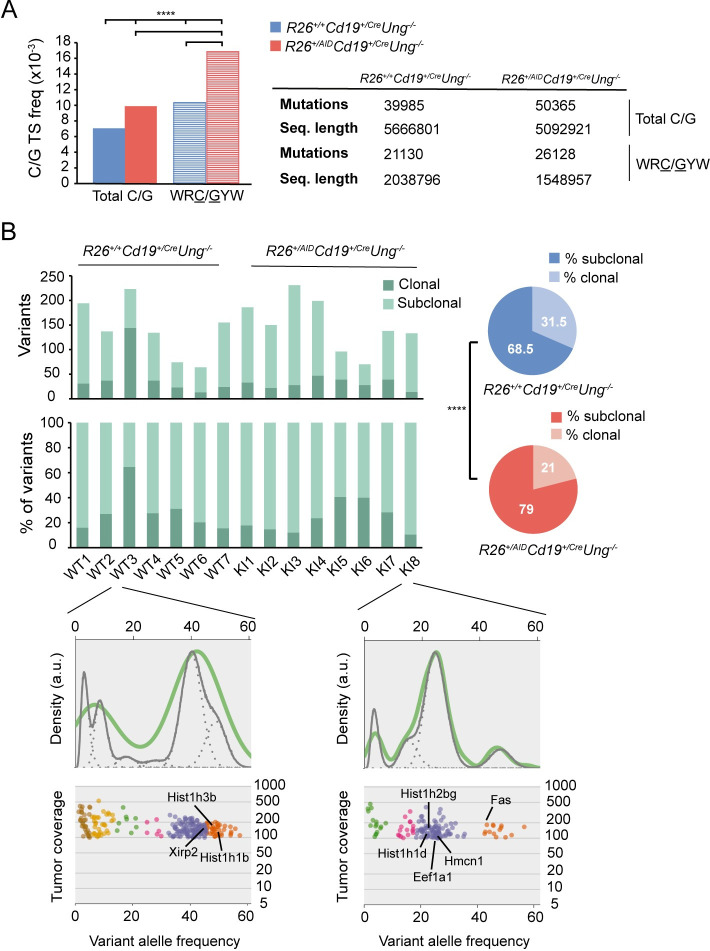
AID contributes to intratumor heterogeneity.(A) Average transition mutation frequency at total C/G pairs and at C/G within WRC/GYW hotspots in tumors from R26+/+Cd19+/creUng-/- and R26+/AIDCd19+/creUng-/- mice as measured by whole exome sequencing (Two-tailed γ2 test; all comparisons -Total C/G vs WRC/GYW within the same genotype; Total C/G AID WT vs AID KI; WRC/GYW AID WT vs AID KI-, p <2.2x10-16). (B) Number (upper panel) and proportion (lower panel) of clonal and subclonal variants in each of the seven R26+/+Cd19+/creUng-/- (WT) and eight R26+/AIDCd19+/creUng-/- (KI) tumors analyzed. Piecharts depict the proportion of clonal and subclonal variants of all the tumors analyzed pooled by genotype (Two-tailed Fisher test; ****p ≤10−4). Inset panels show a representative example of the intratumor heterogeneity in each genotype. Clusters as defined by SciClone are depicted in different colors. Clonal variants are those belonging to the cluster with the highest variant allele frequency (VAF; orange clusters in inset panels), usually between 40–50%. Subclonal variants are those belonging to clusters with a lower VAF than that of the clonal cluster. Density plots depict the posterior predictive density, a surrogate of the accuracy of the prediction model assigning variants to the different clusters (green lines represent the diploid model; grey continuous and discontinuous lines represent the model fit of each cluster and each variant, respectively). Tumor coverage refers to the number of reads supporting each variant. Genes that are frequently mutated in human lymphoma tumors are indicated in black.